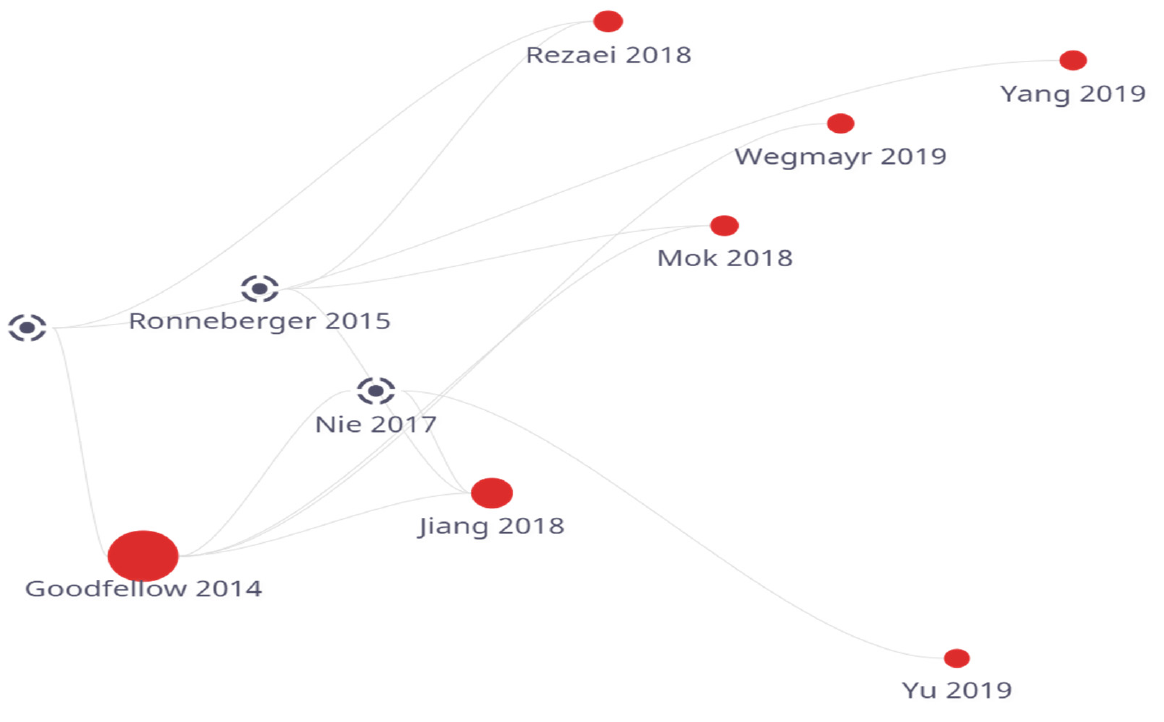
Figure 1. GAN-based model year-wise survey. Table 1 represents the survey conducted on various GAN based models including parameters like methods used, datasets used, computation time and evaluation parameters. It provides a summary of the literature provided at